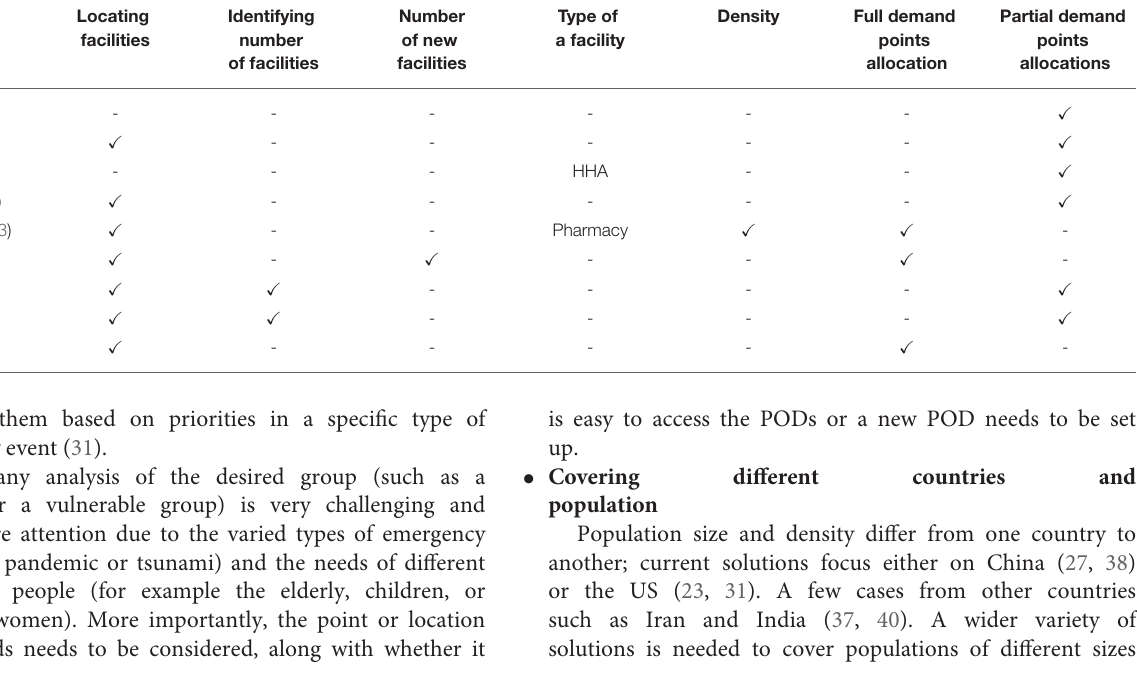
TABLE 7 | A comparison of location-allocation solutions for PODs during public health emergencies based on their key features.